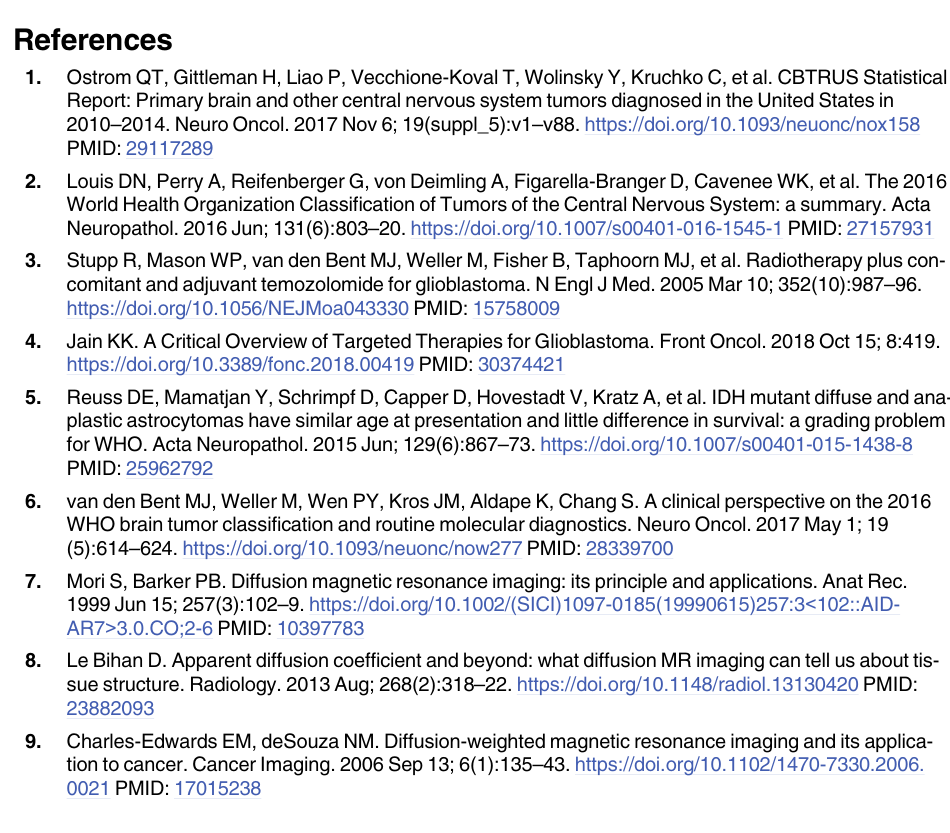
S1 Table. Primary histogram profiling parameters. S1 Table displays all histogram profiling parameters obtained on each patient level as well as the corresponding histopathological infor-